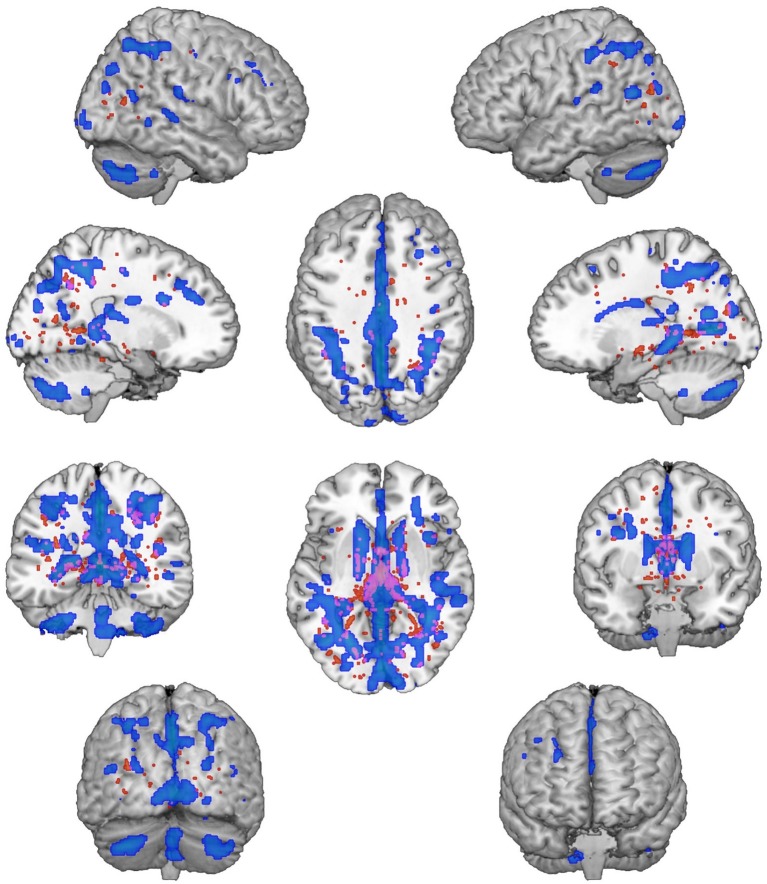
IC06 Pattern. The figure depicts the covariance pattern of IC06 emerging from joint ICA. Statistical maps are thresholded at z = 2.5 for visualization purposes. Gray-matter clusters and white-matter clusters including all DTI metrics (i.e., FA, MD, AD, RD) are shown in blue-green and red-yellow colors, respectively.